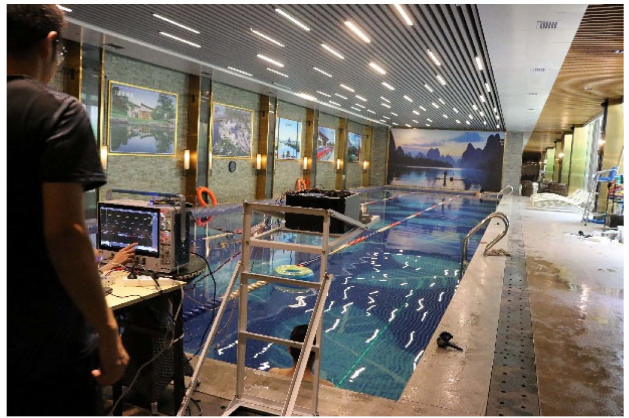
Figure 22. The overall physical diagram of the pool experiment.